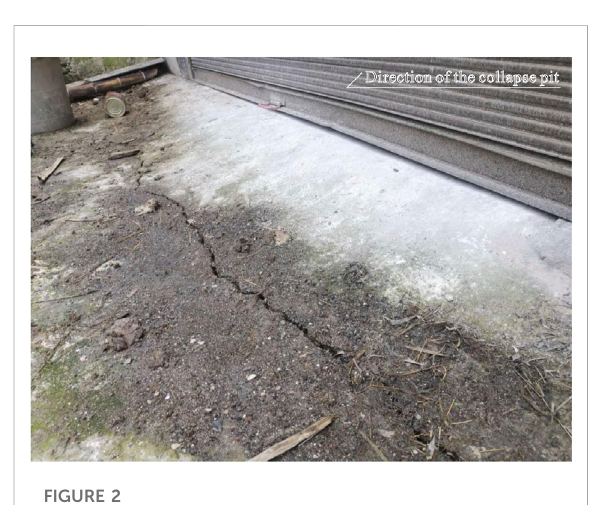
FIGURE 2 Tensile cracks in the garage of house No. 3.